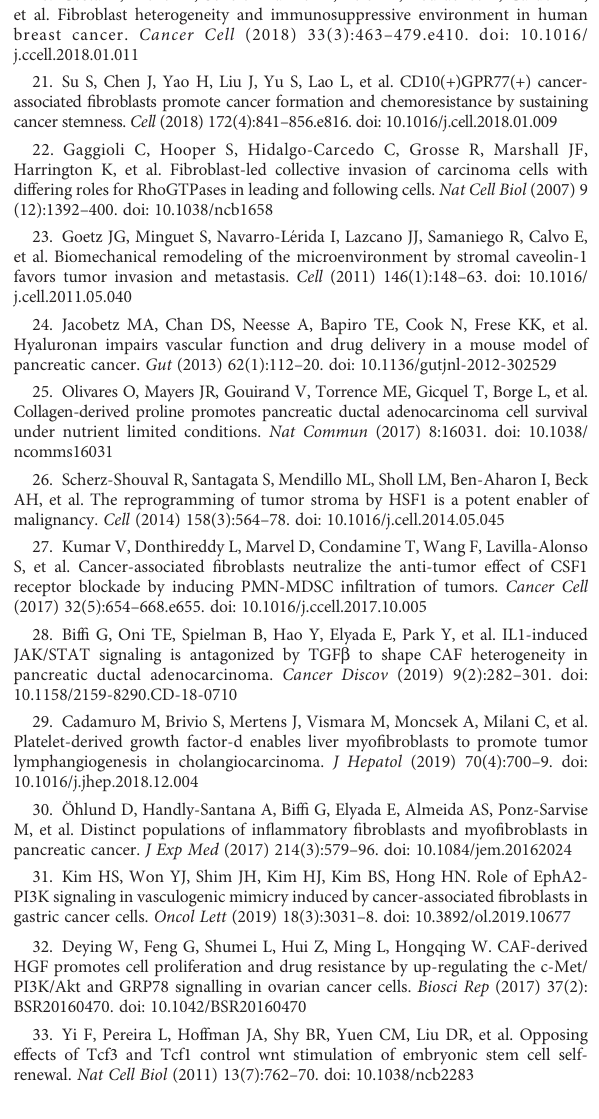
SUPPLEMENTARY FIGURE 1 (A) Correlation between mitochondrial genes and UMI/mRNA quantity as well as between UMI and mRNA quantity; (B) Correlation among the mRNA/UMI/mitochondrial content/rRNA content of samples before fi ltration; (C) Correlation among the mRNA/UMI/mitochondrial content/ rRNA content of samples after fi ltration; (D) Dimensionality reduction and identi fi cation of anchor points via PCA.